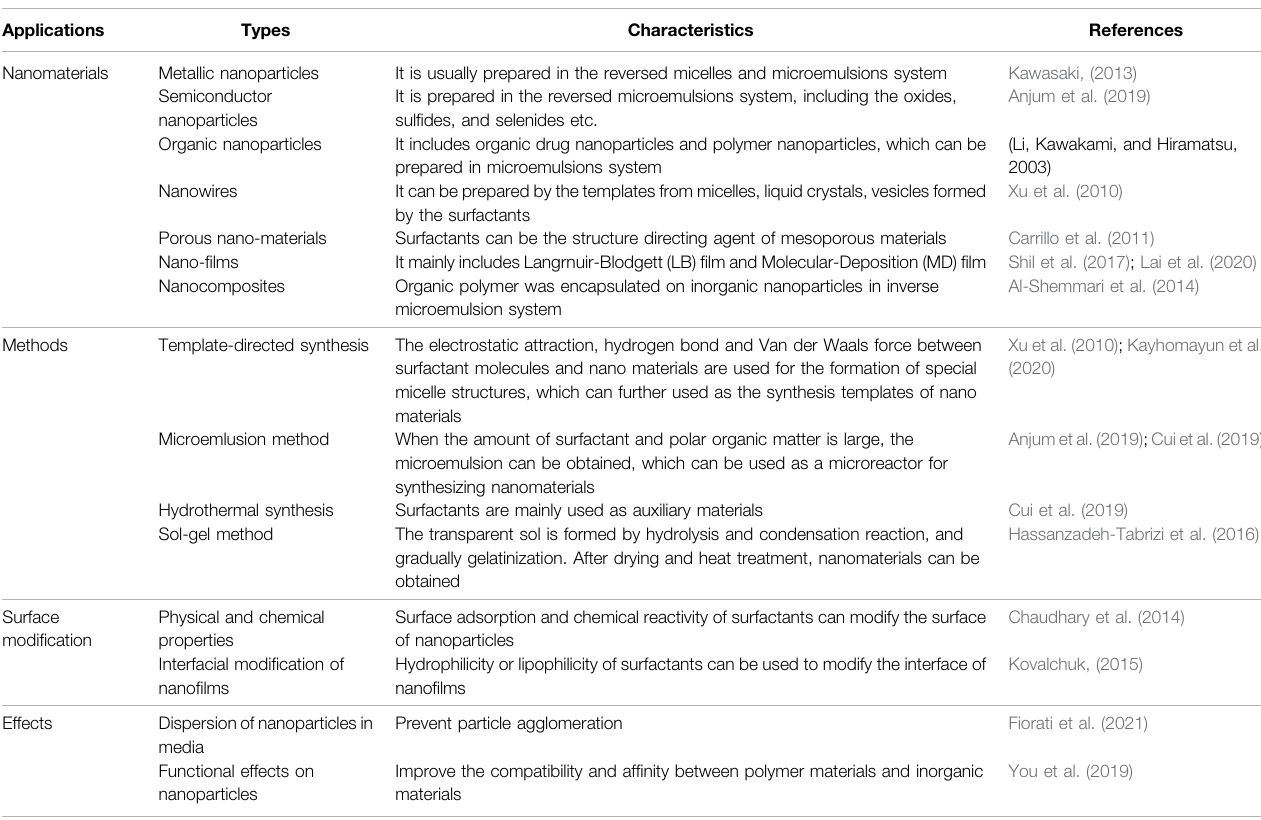
TABLE 2 | Applications of surfactants in preparing